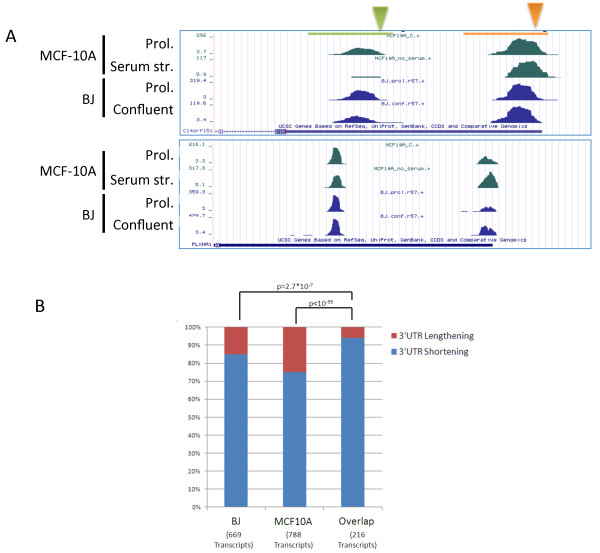
Core set of genes with shortened 3' UTRs in proliferative state. (a) Examples of transcripts with shortened 3' UTRs in the proliferative state compared to the arrested one in both BJ and MCF10A cells. Proximal and distal CSs are indicated by green and orange triangles, respectively. (b) The set of 216 transcripts that showed consistent change in 3' UTR length in both BJ and MCF10A cells was significantly enriched for genes with shortened 3' UTRs in the proliferative state (the increase from 83% and 75% to 94% is highly significant; P-values calculated using geometric tail).